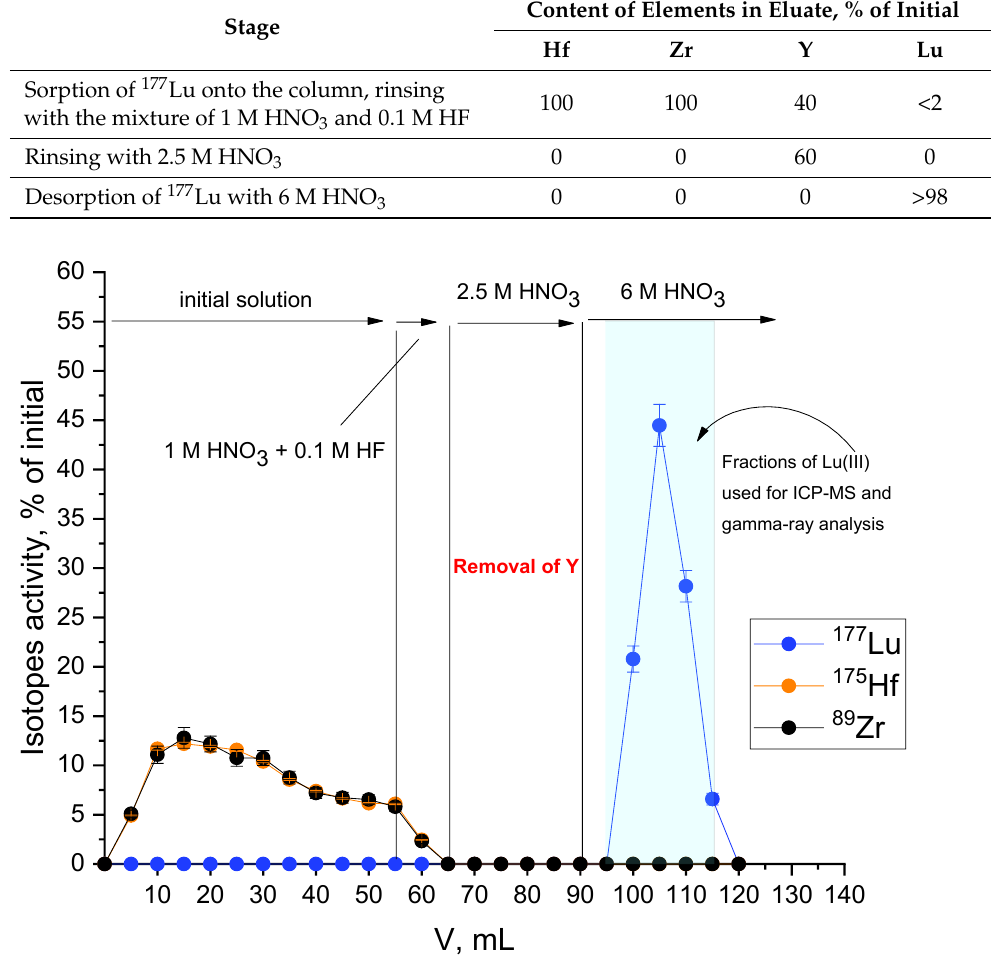
Figure 2. Elution curves of Hf, Zr, and Lu in developed recovery method. Activities of Y isotopes were too low to make its elution curve.